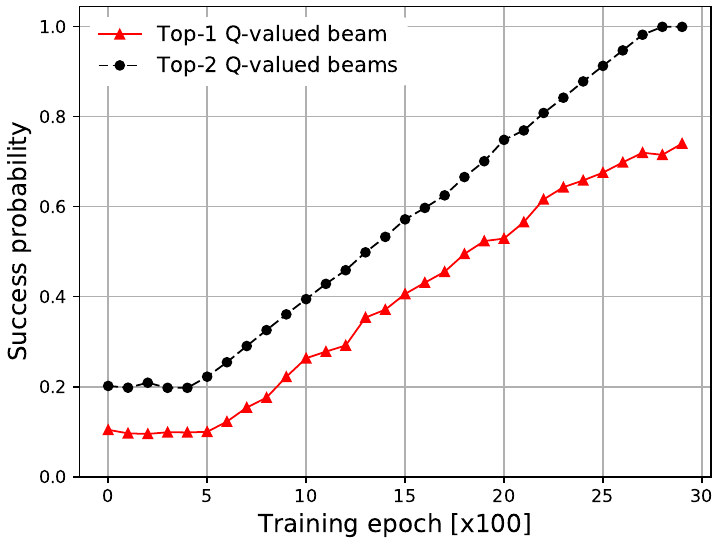
Figure 3. Success probability of selecting optimum beamforming vector vs. iteration